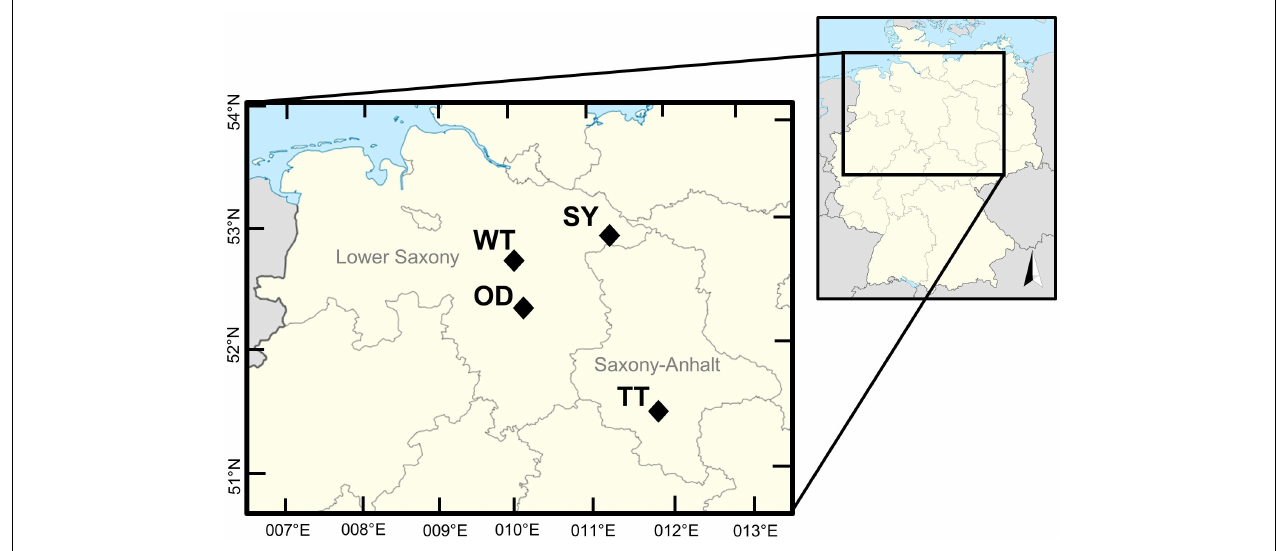
FIGURE 1 | Sampling locations in Lower Saxony and Saxony-Anhalt (OD, Oedesse; SY, Shreyahn; TT, Teutschenthal; WT, Wietze; NN not